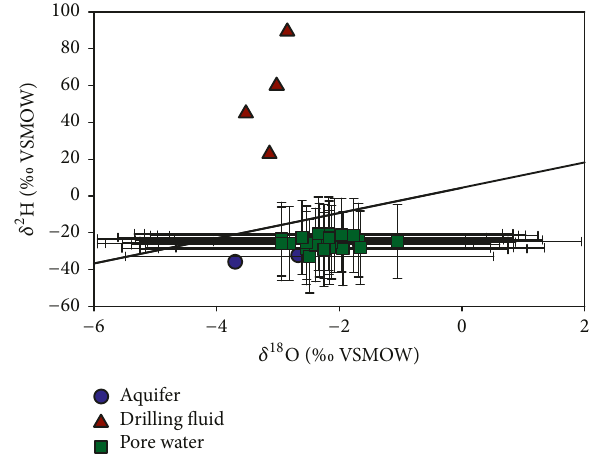
Figure 2: 𝛿 18 O and 𝛿 2 H in pore water, groundwater, and drilling fluid samples. Error bars represent the possible isotopic equilibrium fractionation difference for samples with less than 3 g water adapted from Hendry et al. [50]. The black line represents the local meteoric water line (LMWL), 𝛿 2 H = 7.2 𝛿 18 O + 5.7, from Alice